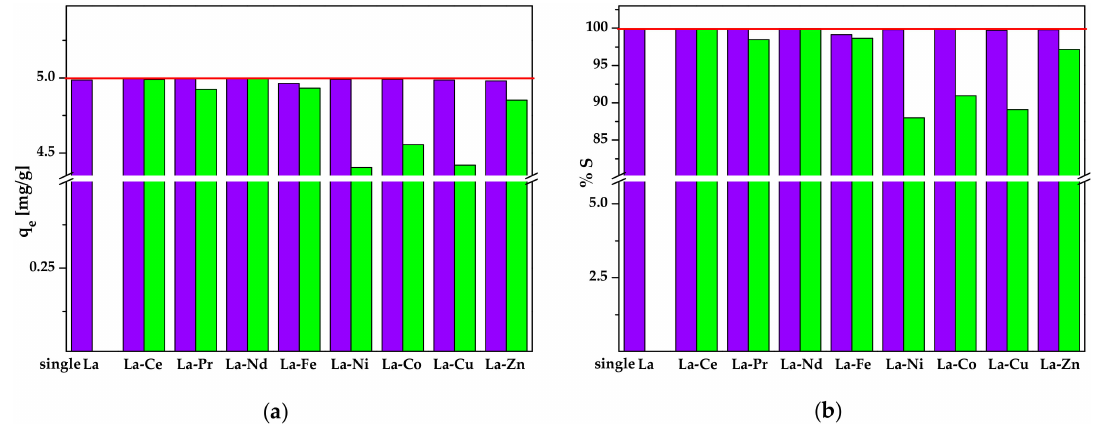
Figure 13. ( a ) Equilibrium sorption capacities and ( b ) Sorption percentages of La(III) ions in the di ff erent sorption